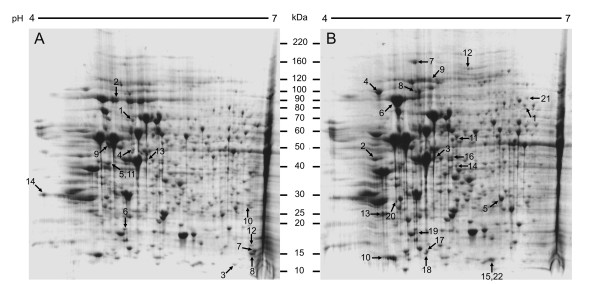
Proteome maps of K562 (A) and Lucena (B) cell lines. Nine hundred micrograms of total protein extract were separated by electrophoresis on IPG (pH 4-7) and gradient (8-18%) SDS-PAGE gels. 2-DE gels were stained with coomassie colloidal blue (CBB). The migration of molecular mass markers is represented in the middle. Numbers refer to the spot identity used in table 1. Arrows correspond to the differentially expressed proteins according to ImageMaster 2D Platinum software.